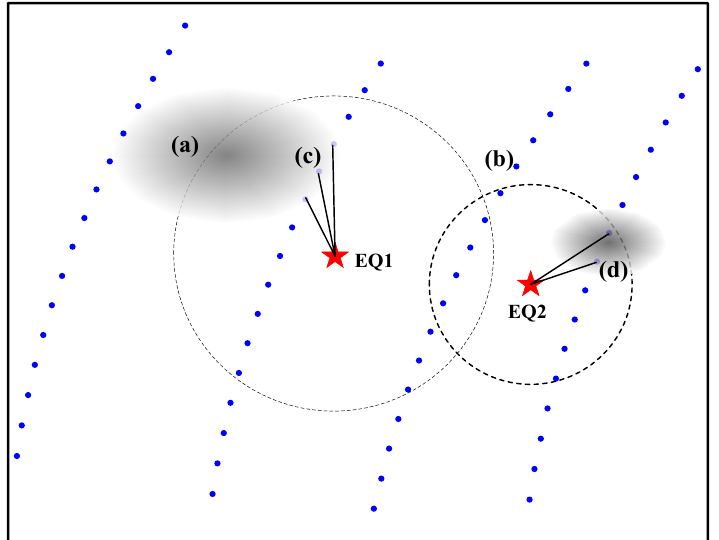
Figure 7. Schematic map of relative position between satellite orbit and seismic ionospheric anomaly, showing the datapoints on the orbit (blue dots), earthquake epicenters (red star), the areas of Dobrovolsky’s radius R around epicenters (dashed circles), and presumed anomalies (gray shadows). ( a – d ) in the figure represents different states of the relationship between anomaly position and data acquired. See details in the text.